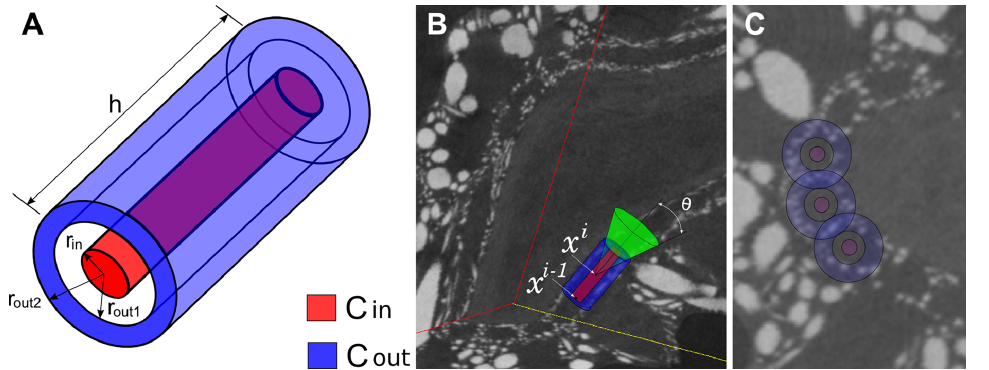
Figure 8. Cylinders used to estimate the local orientation. (A) C in , C out and their dimensions. (B) C in , C out aligned with a canal at the previous point x i { 1 , and the cone used to seek for the current orientation. Note the definition of the angle h and the location of the current point x i at h = 2 from x i { 1 . (C) Disks and rings corresponding to C in , C out of three neighboring canals in the initial cross-sectional plane.